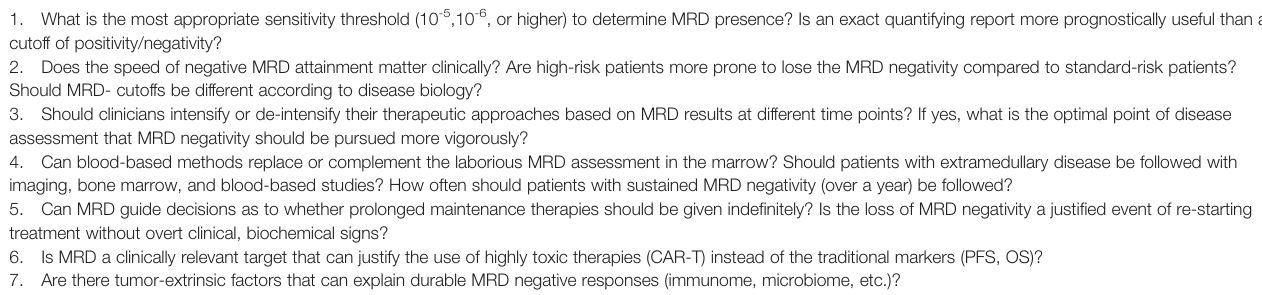
TABLE 4 | Barriers for regular use and future prospects of MRD assessment in